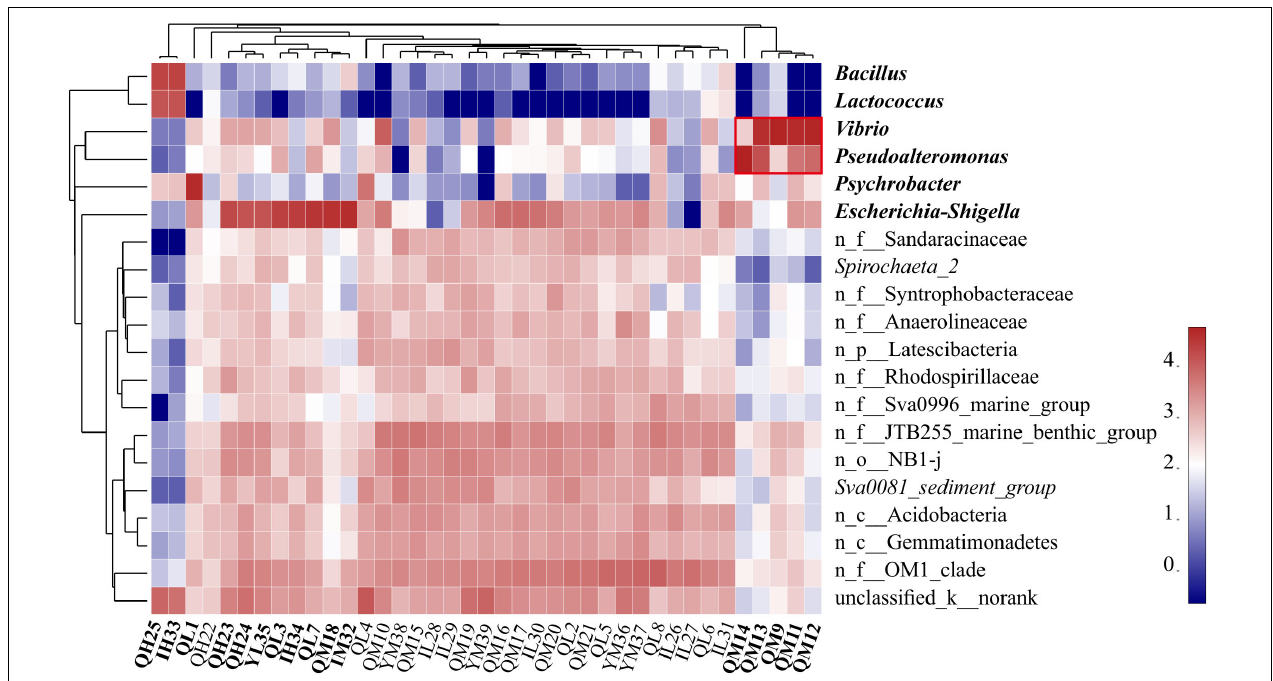
FIGURE 2 | Heatmap of the relative abundance of the top 20 genera of all sediment samples. Clusters based on microbial community composition are above the heatmap, clusters based on the genera are on the left of the heatmap, and special samples and bacteria are shown in bold. n_ indicates no rank. The data were scaled per column. The values represent the relative abundance of genera in the